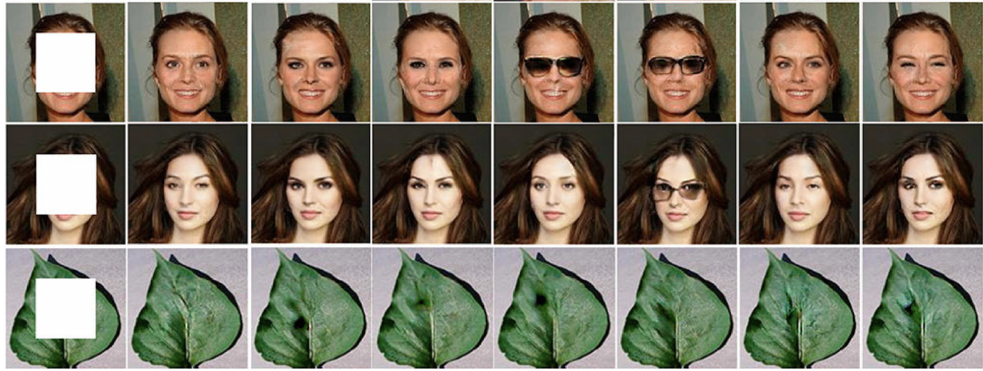
Figure 16. Examples of inpainting results produced by PiiGAN on two faces and a leaf. On the left column is the input image (with the center pixels removed). The images in the remaining columns are outputs of the PiiGAN. Image taken from